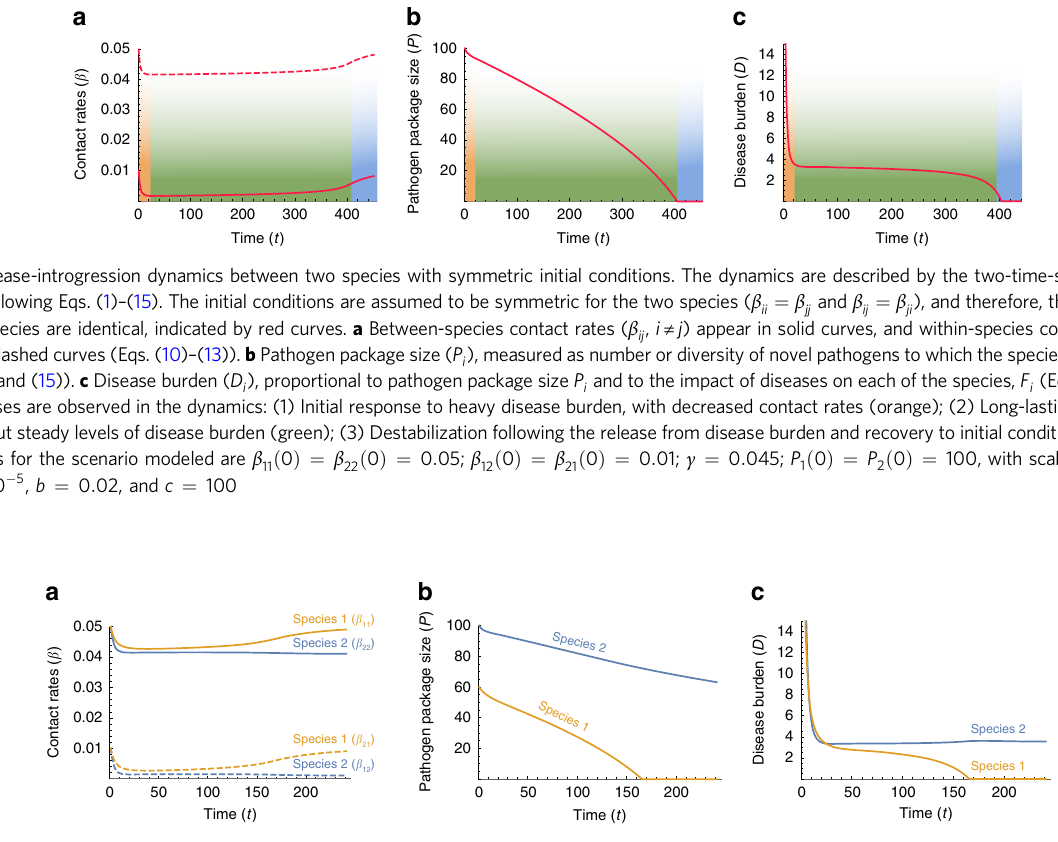
Fig. 4 Disease-introgression dynamics between two species with asymmetric initial conditions. The dynamics of the two-time-scales model are described by Eqs. (1) – (15), with parameters identical to those in Fig. 3 except that species 1 (orange) is initially exposed to a smaller pathogen package than species 2 (blue), i.e. species 2 experiences more novel pathogens at the time of contact; P 1 ð 0 Þ ¼ 60, P 2 ð 0 Þ ¼ 100. a Between-species contact rates ( β ij , i ≠ j ) appear as dashed curves, and within-species contact rates ( β ii ) appear as continuous curves (Eqs. (10) – (13)). b Pathogen package size, P i . c Disease burden, D i . Species 1 experiences a lower disease burden at the initial phase, and therefore responds less strongly and maintains higher contact rates (in a ). This higher contact rate leads to faster rates of adaptive introgression into species 1 (in b ). Finally, species 1 is released from disease burden sooner than species 2 (in c ), while still carrying many pathogens to which species 2 is vulnerable (in b